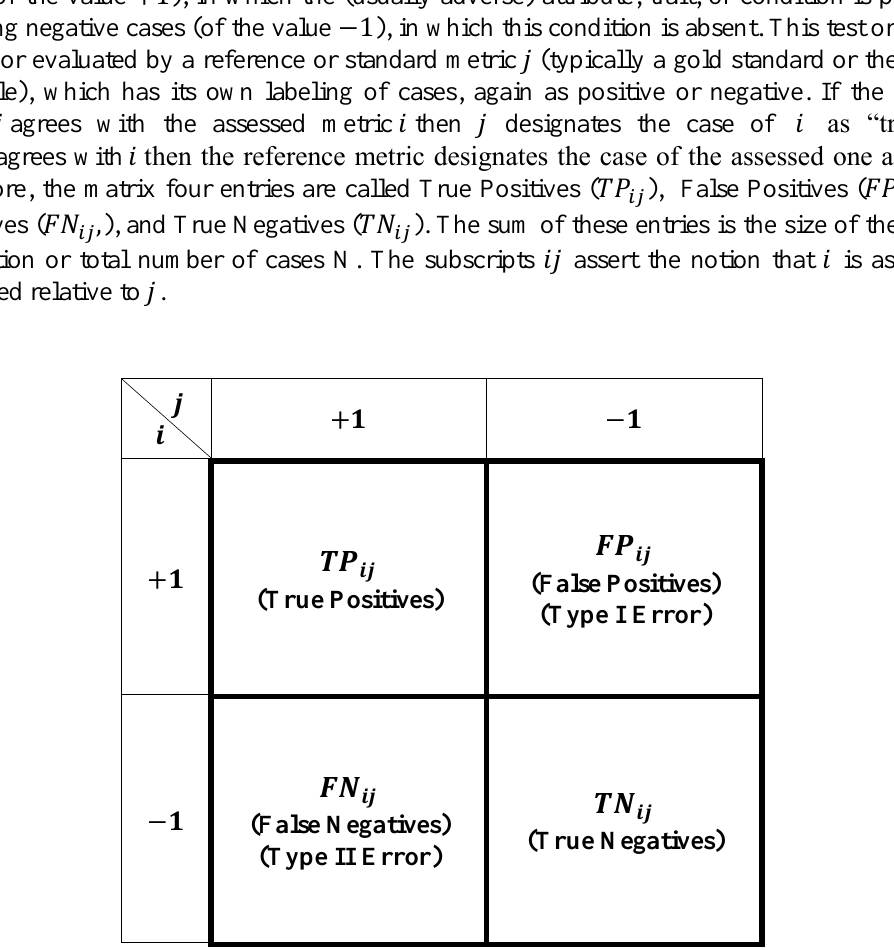
Figure 1. The two-by-two contingency matrix of test or metric 𝑖 with respect to test or metric 𝑗 . This matrix has integer entries that add to the total number of cases 𝑁 . (Typically, 𝑗 represents reality as a gold standard while 𝑖 is a measure to be